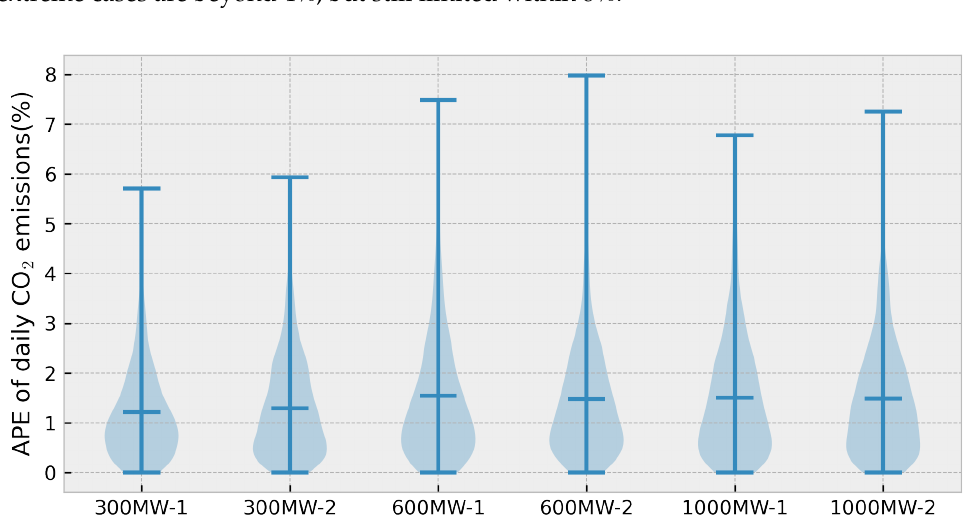
Figure 16. Analysis of uncertainty of EEN according to estimated daily CO 2